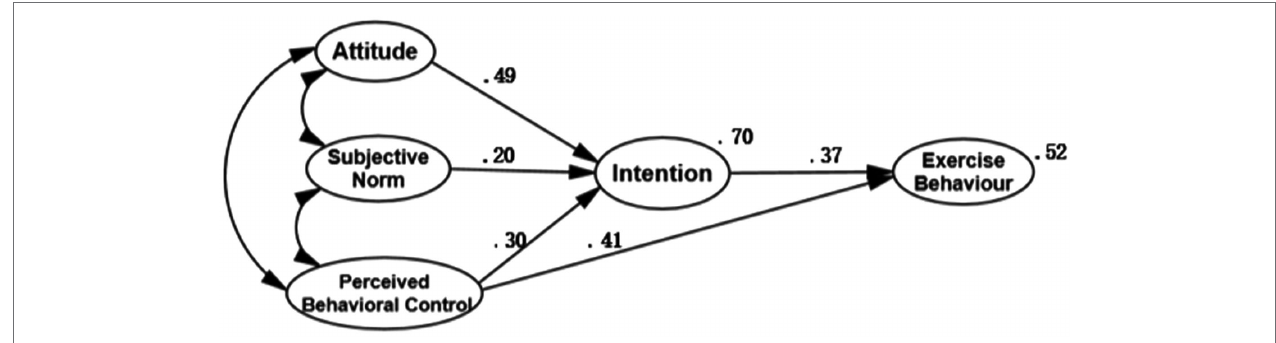
FIGURE 2 | Path coefficient diagram of structural equation model for TPB-5.